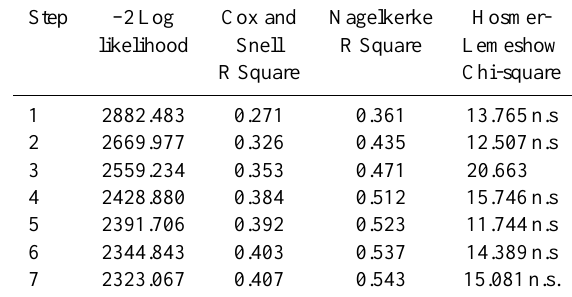
Table 2. Logistic regression results and coefficient values used for this study.